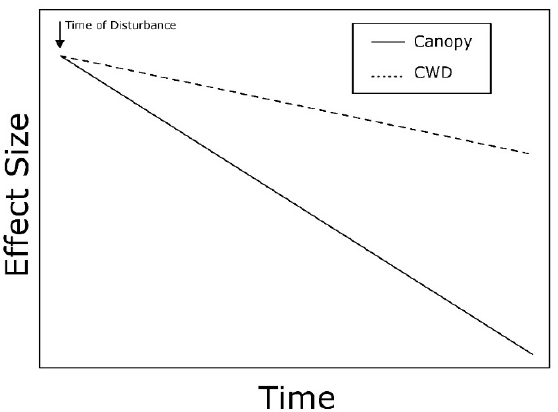
Figure 2. Conceptual model depicting the predicted temporal relationship between the effect sizes of canopy gaps and accumulation of coarse woody debris (CWD) caused by wind disturbance on ground-dwelling invertebrate communities. Time of disturbance denotes the windthrow event.